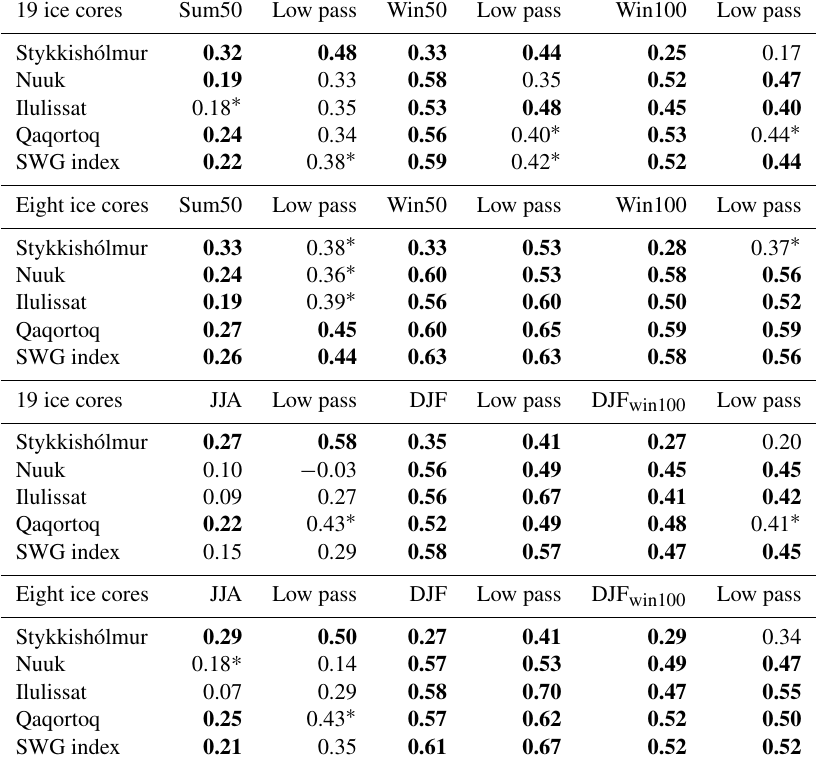
Table 4. Correlation between reconstructed and observed temperature for Greenland coastal stations (1874–1970) and the Icelandic sta- tion, Stykkishólmur (1831–1970). Bold marks p < 0 . 05; the symbol ∗ marks p < 0 . 10. The low-pass filter is a decadal FFT (fast Fourier transform)